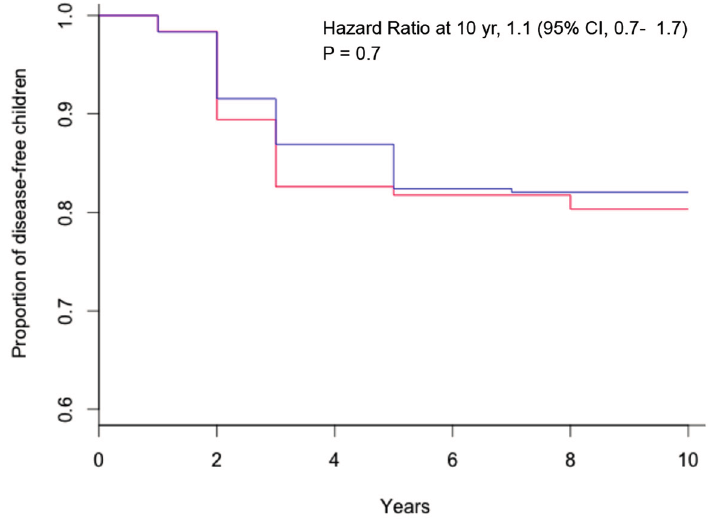
Figure 1. Kaplan–Meier estimates of celiac disease, according to breastfeeding (red = no breastfeeding; blue = any